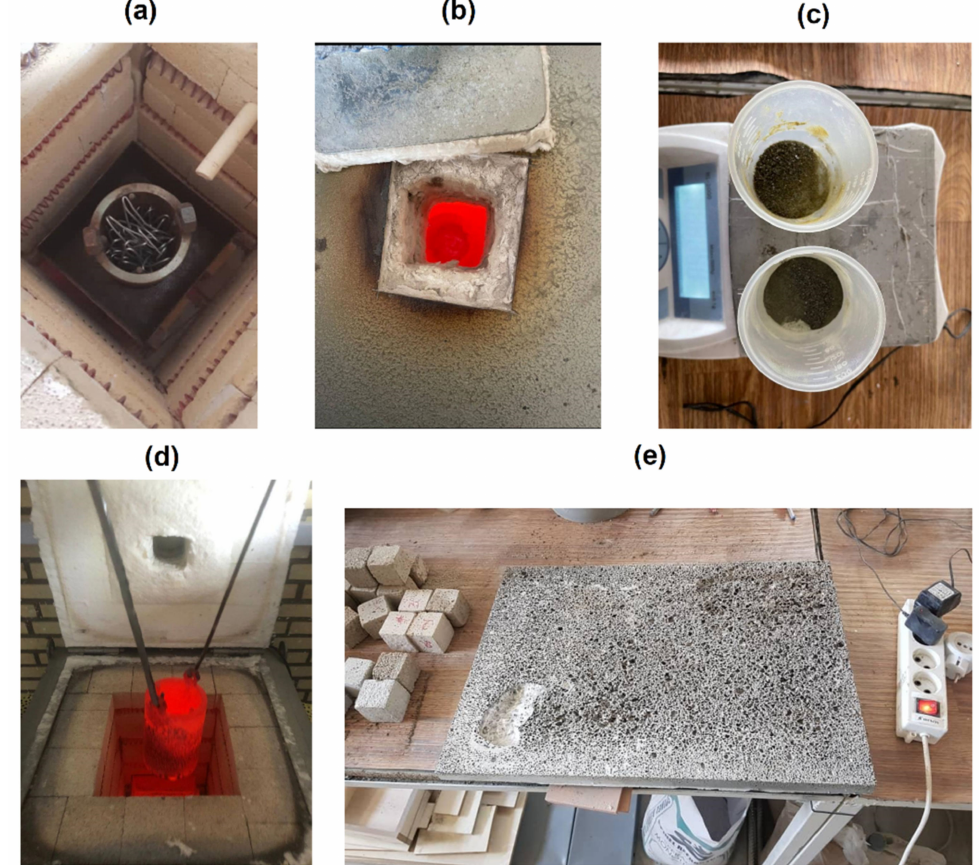
Figure 4. The equipment used for producing foam: ( a ) Aluminum charging, ( b ) Melting process, ( c ) Weighing powders for adding to melt, ( d ) Pouring melt into a steel mold, and ( e ) Solid